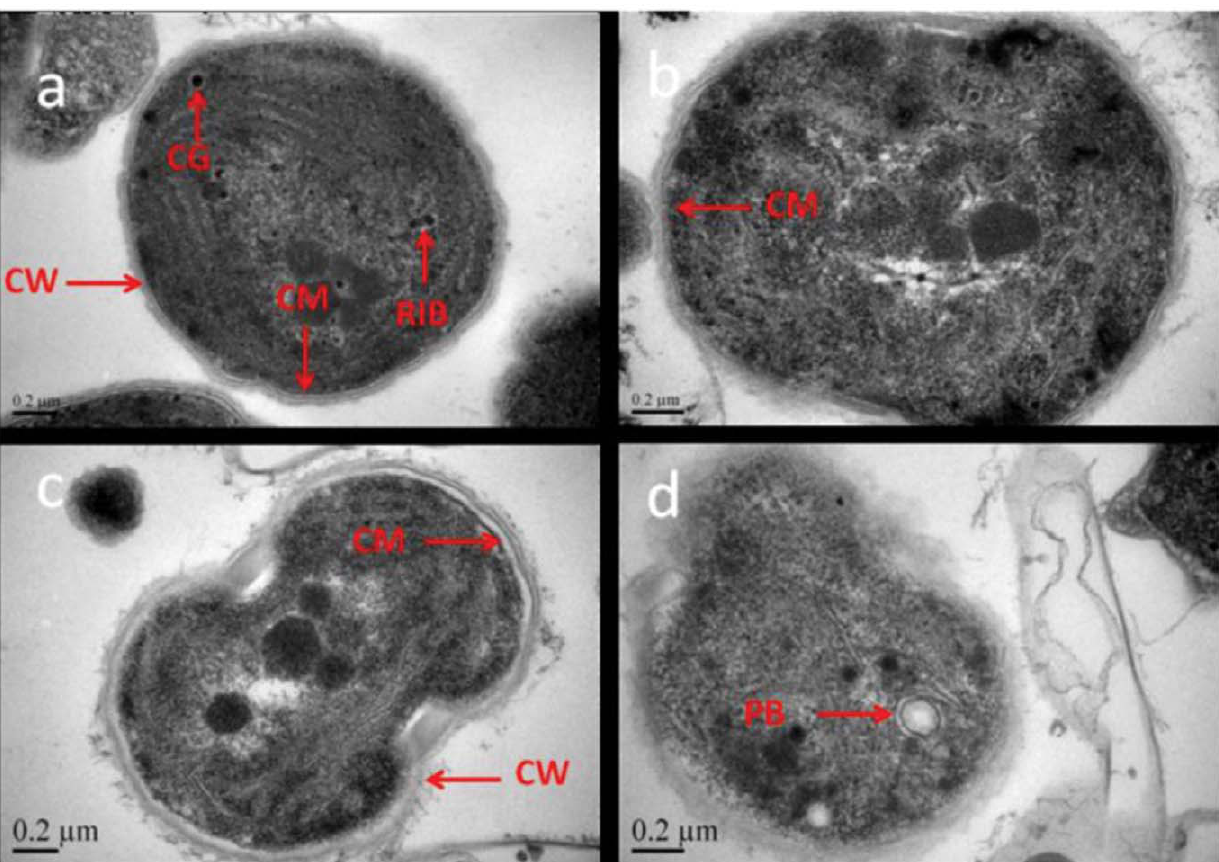
Figure 5. Biological degradation process of M.aeruginosa FACHB-905 by Streptomyces sp. HJC-D1: (a) normal cell; (b) cell walls becoming detached; (c) release of cellular contents; (d) broken cell. CW, cell wall; CM, cell membrane; PB, polyphosphates bodies; CG, cyanophycin granules; RIB, ribosomes.